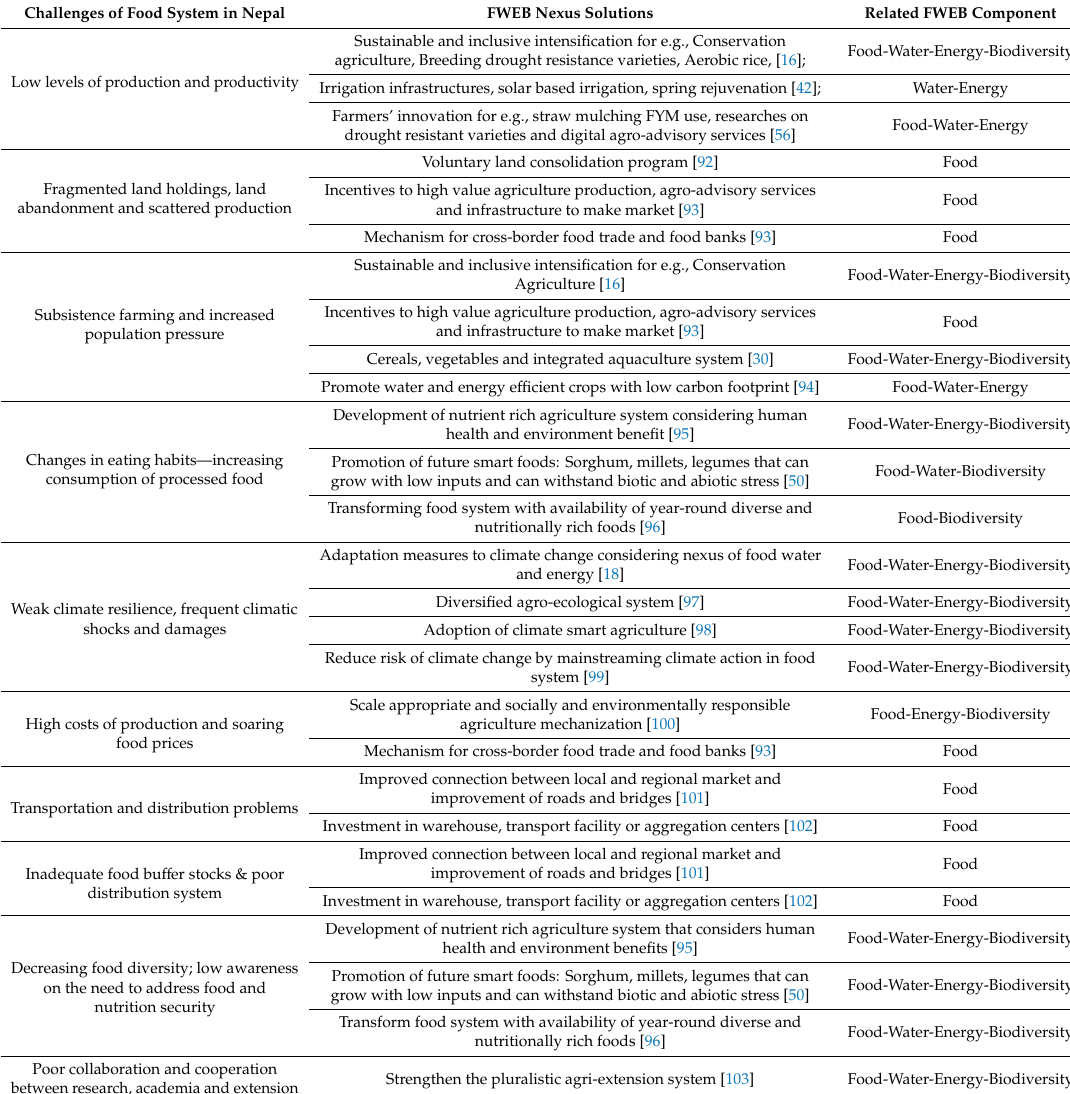
Table 4. Challenges of the food system in Nepal and the food–water–energy–biodiversity (FWEB) nexus